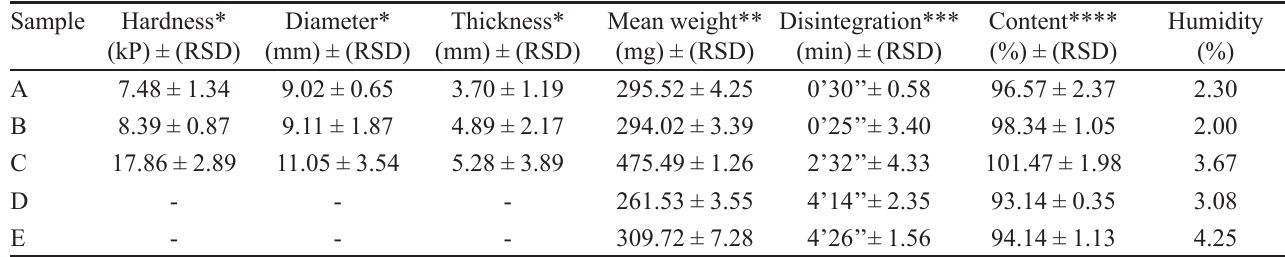
TABLE II - Results of hardness, diameter, thickness, mean weight, disintegration, content and moisture tests of 200.00 mg carbamazepine tablets and